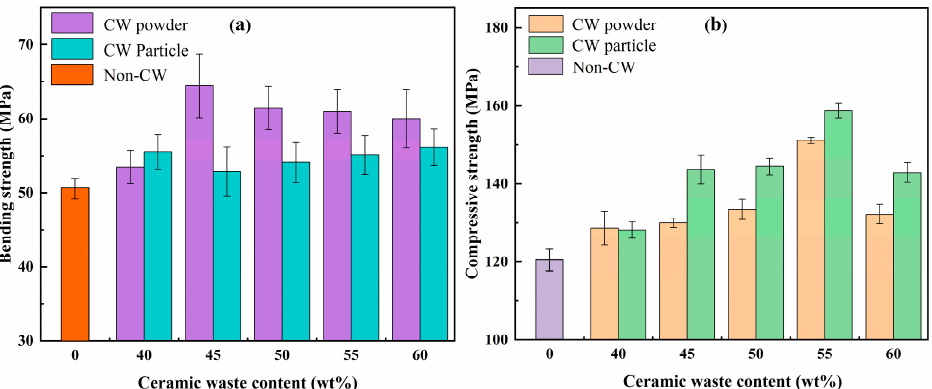
Figure 5. ( a ) Bending strength and ( b ) compressive strength of artificial stones with different particle content and particle size of ceramic wastes.